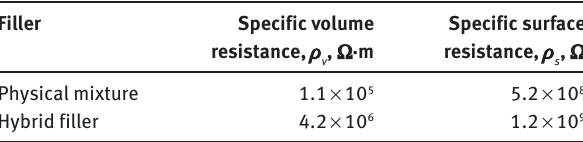
Table 6: Specific volume resistance and surface resistance of composites comprising the hybrid carbon black-magnetite filler and of composites filled with the physical mixture of carbon black and magnetite.